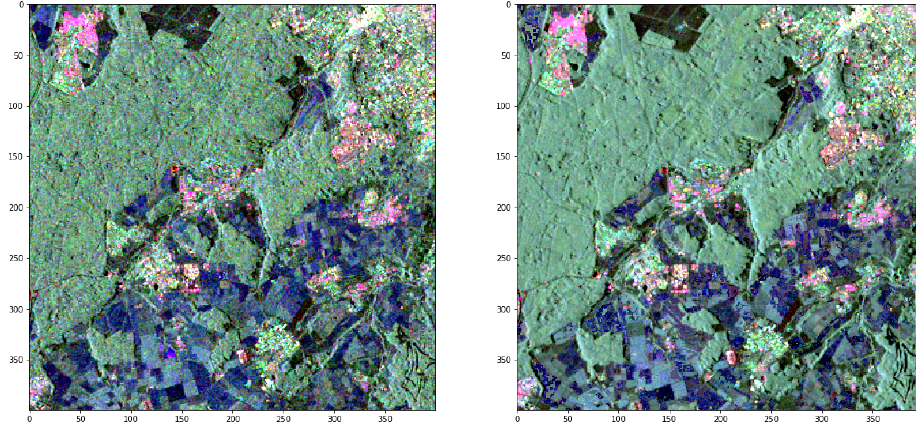
Figure 4. Comparison of a RADARSAT-2 quad-polarized image acquired over an area southwest of Bonn, Germany on 11 Oct 2010 ( left ) with the ATSF derived from a sequence of 12 images from 25 May 2009 through to 11 Oct 2010 ( right ). The images are in the Pauli representation ( R = | S hh − S vv | 2 , G = | S hv | 2 , B = | S hh + S vv | 2 ). RADARSAT-2 Data and Products c (cid:13) MacDonald, Dettwiler and Associates Ltd. (2009–2010) — All Rights Reserved. RADARSAT is an official trademark of the Canadian Space Agency.